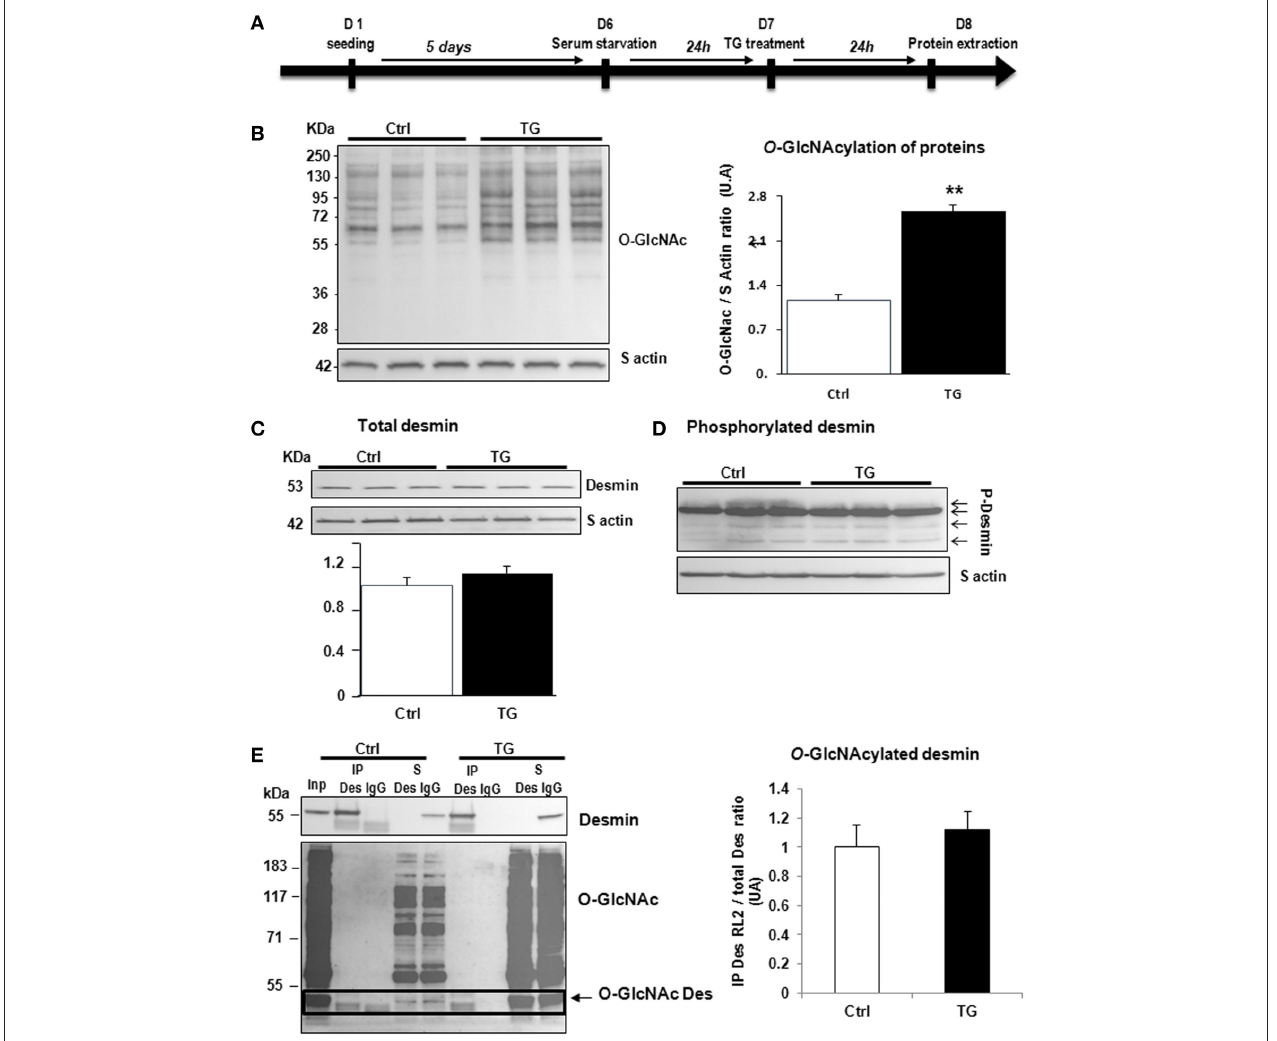
FIGURE 2 | Impact of OGA inhibition by thiamet G in primary cultures of NCM. (A) Description of the protocol designed for Thiamet G (TG) treatment of primary culture of neonate cardiomyocytes (NCM). (B) Representative western blots (left panel) and quantification (right panel) of O-GlcNAcylated proteins levels in control (Ctrl) and NCM treated with 100nM of thiamet G (TG) during 24h ( n = 12). (C) Western blots (upper panel) and quantification (lower panel) of total desmin levels in the same samples. (D) Phosphorylation profiles of desmin were analyzed in the same samples by Phos-tag TM gel. (E) Representative immunoprecipation (IP) with desmin antibody before western blot with RL2 antibody (left panel) and quantification (right panel) of O -GlcNAcylated desmin levels in the same samples. Inp, input; IP, immunoprecipitated proteins; S, IP supernatant; Des, desmin; IgG, Immunoglobulin. The arrow indicates the O -GlcNAcylated desmin. Data are expressed as means of an arbitrary unit (A.U.) ± SEM. The positions of molecular weight are indicated as kilodalton (kDa) on the left. ** P < 0.01.